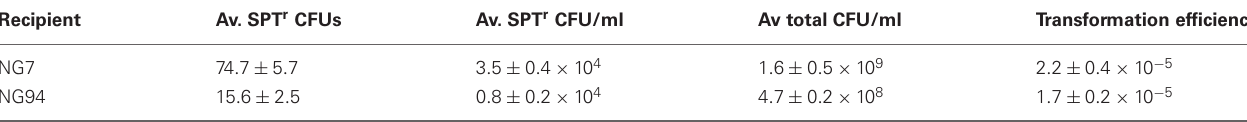
Table 3 | The calculated results of transformation experiments. Recipient